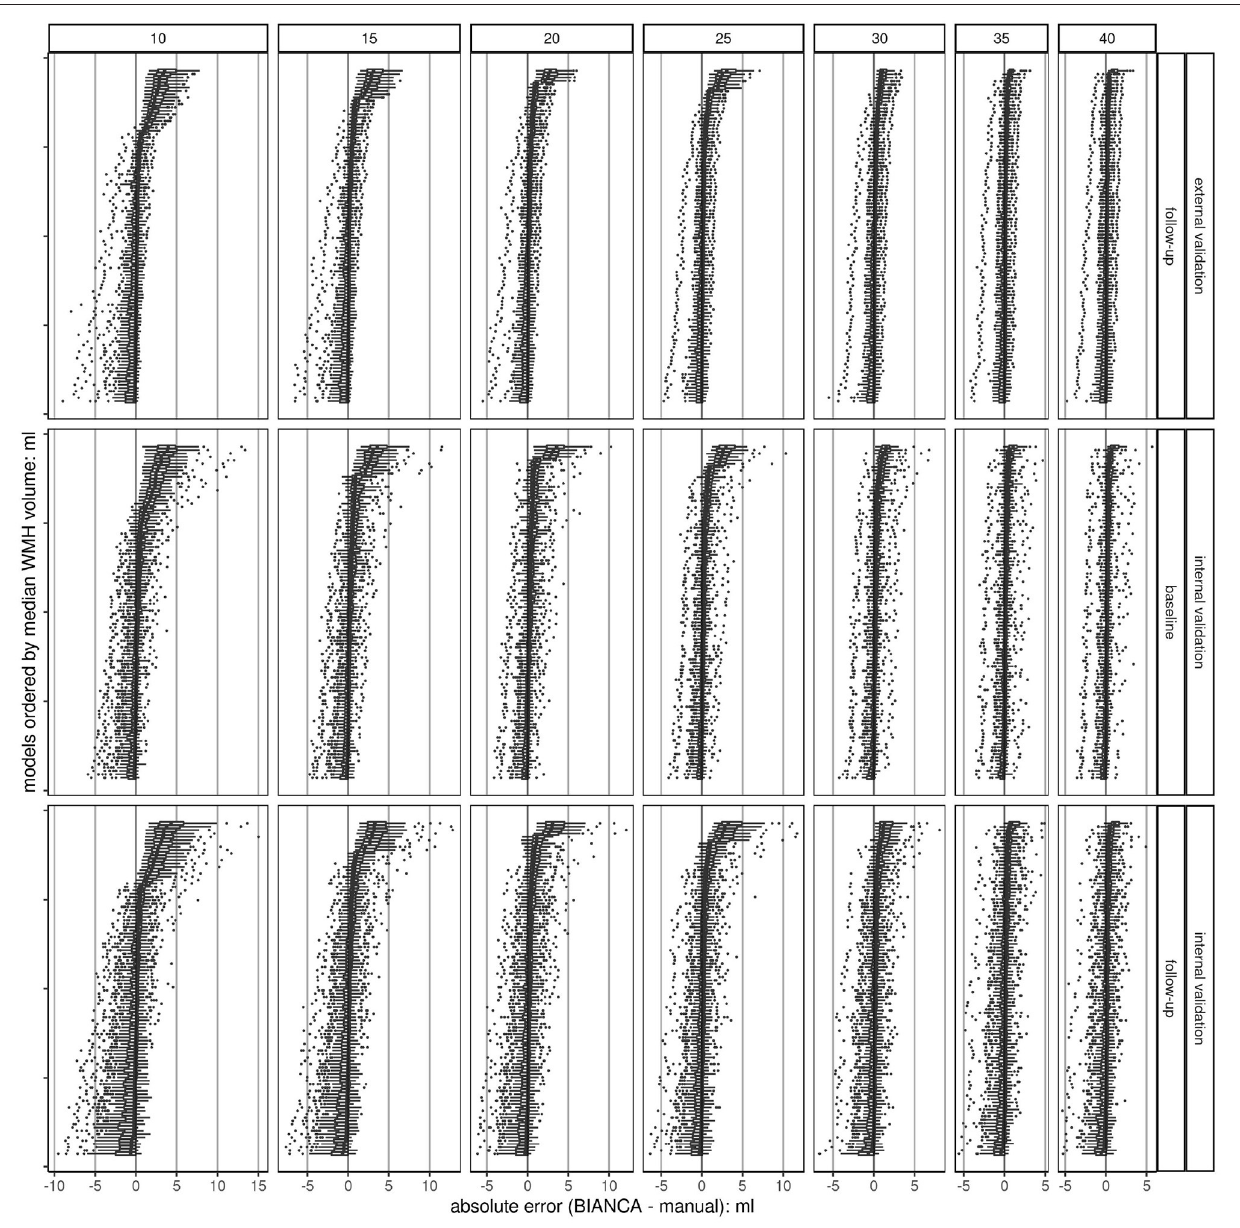
FIGURE 4 | Boxplots of absolute errors (BIANCA predicted volume - manually delineated volume) per trained BIANCA model ordered by median values. Overall, there are 700 models (100 per sample size) at a threshold of 0.8; each dot represents a single observation. The plots are stratified in a grid, horizontally by sample size ( n = 7) and vertically by validation set ( n = 3). The higher the sample size, the higher the chance to train a model with a low deviation from the gold standard (smaller range, less outliers, and smaller IQR). This shows a convergence of the accuracy of the models with increased sample size resulting in a more robust performance. The black line indicates the ideal absolute error (BIANCA - manual volume) of 0. Absolute errors greater than 0 show an overestimation of BIANCA, while absolute errors smaller than 0 show an underestimation. Figure 4 . We focus on the mean absolute error per model ( n = and algorithm predicted volume per model, sample size, 700; 100 random draws of training sets per 7 sample sizes) across and validation set was visualized with line plots ( Figure 6 ). the validation sets. The boxplots give insights into the accuracy The underlying dot pattern is visualized with a scatter plot per model, while all boxplots together indicate robustness. We ( Supplementary Figure 1 ). Both of these show the accuracy also visualized the performance with two Bland-Altman like plots of each model with increasing sample size. Furthermore, each ( Supplementary Figures 6, 7 ). Supplementary Figure 6 shows model is visualized with a separate boxplot ( n = 700) of absolute the mean and SD of each model separately by sample size errors (BIANCA-manual volume) over these sets shown in